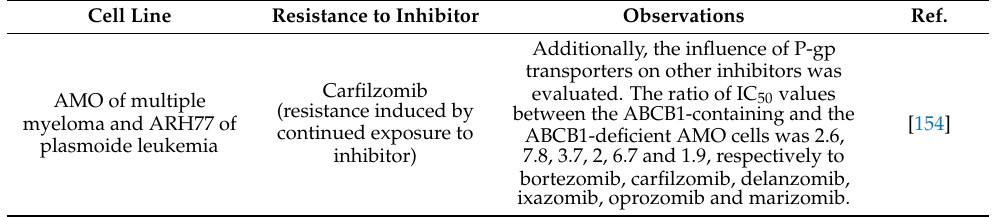
Table 3. Examples of studies that identified situations of resistance to 20S CP inhibitors mediated by P-gp efflux